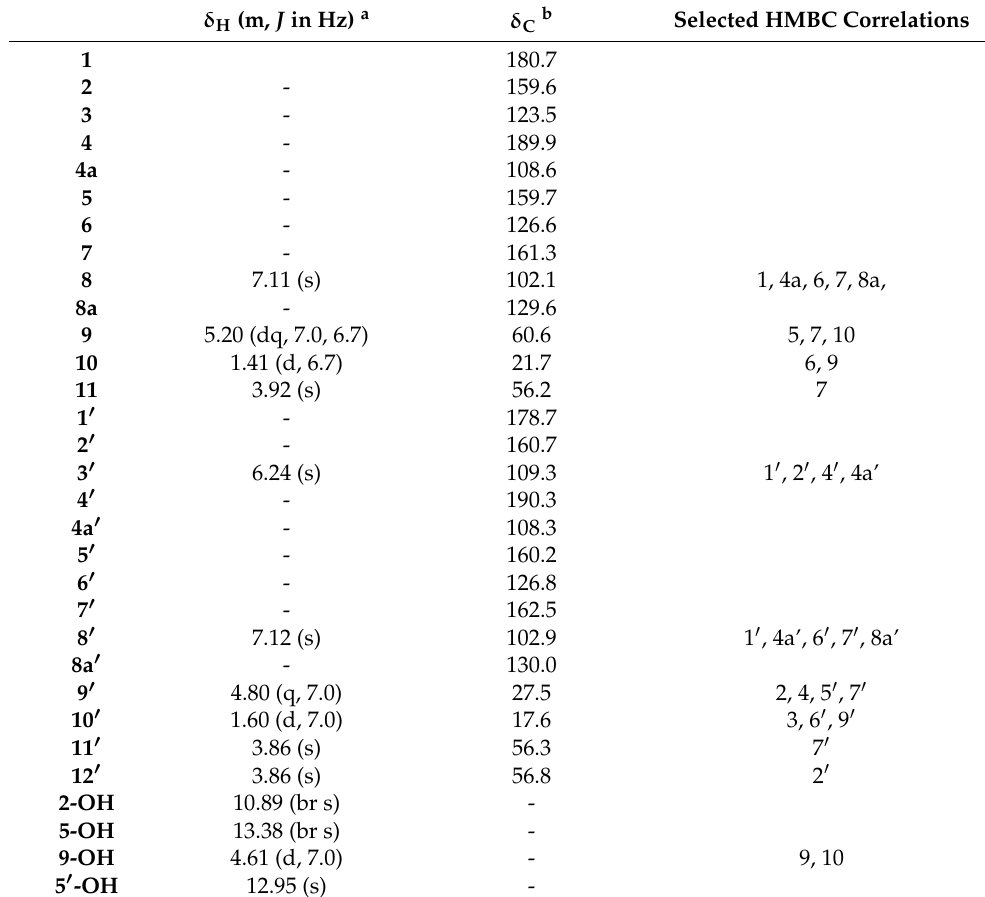
Table 1. 1 H and 13 C-NMR data for compound 1 (DMSO- d 6 ).